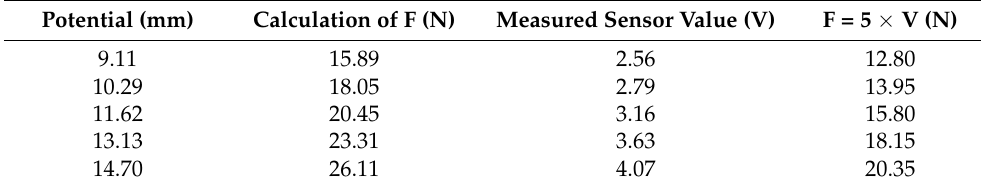
Table 4. Accelerometer reference and measured values on the experimental setup (given the coeffi- cient value of the MEMS accelerometer is 5 [37]).